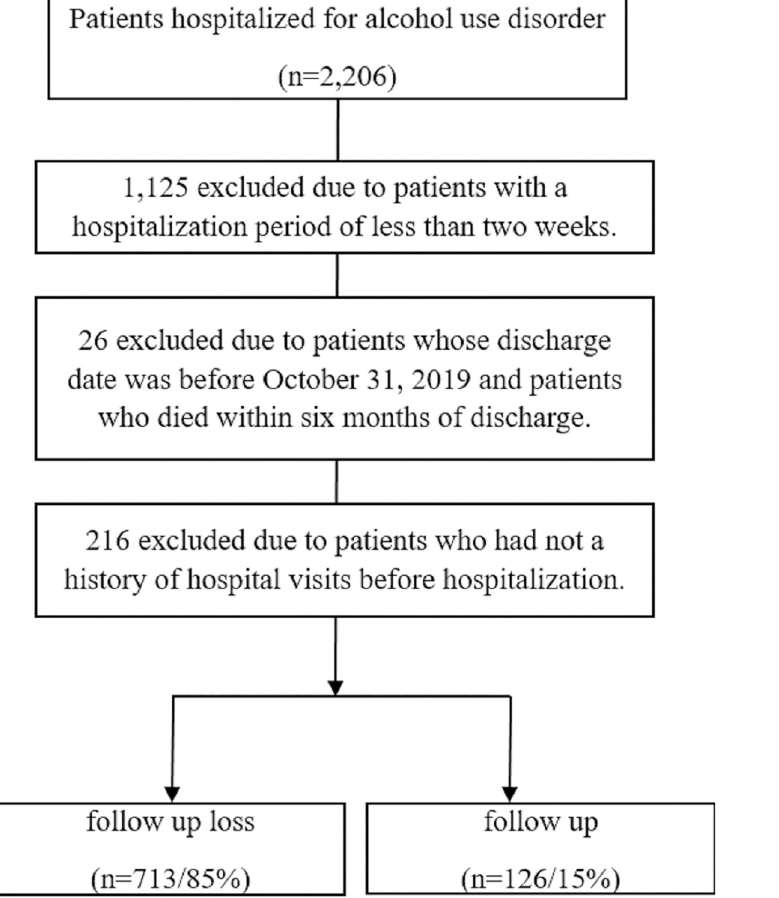
Fig 1. Flow chart of inclusion of